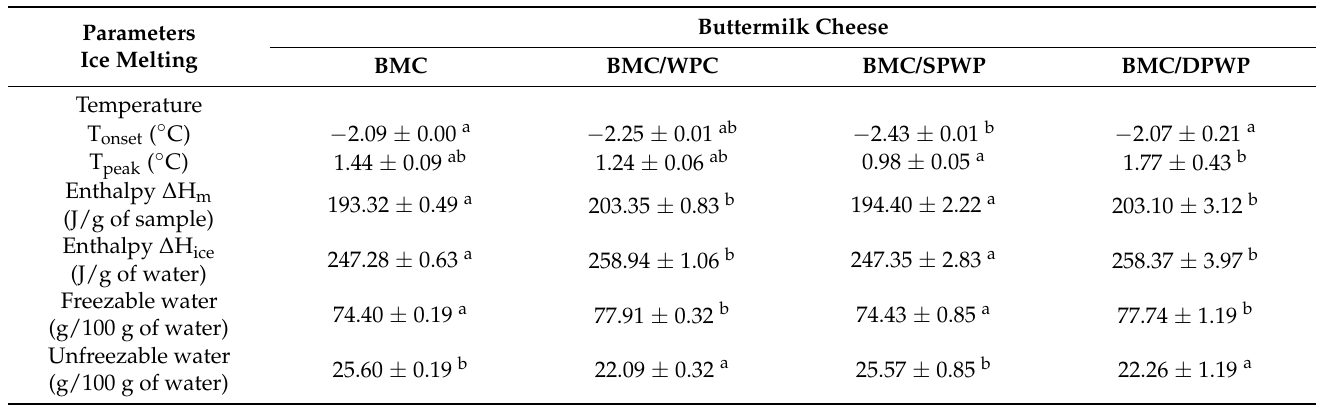
Table 1. DSC parameters of buttermilk cheese with polymerized whey